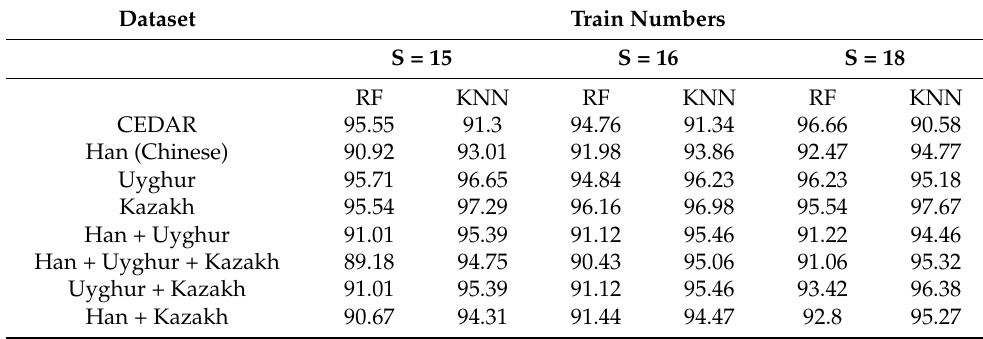
Table 9. Results of different language recognition based on LomoHOG